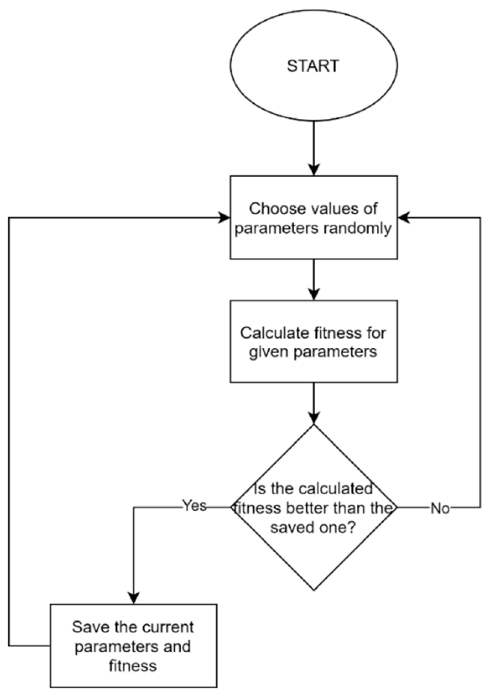
Figure 4. The random search algorithm.